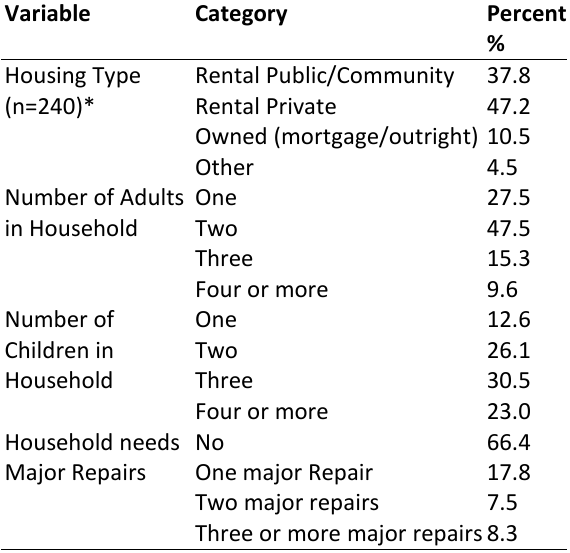
Table 3. Study child’s household (Wave 6